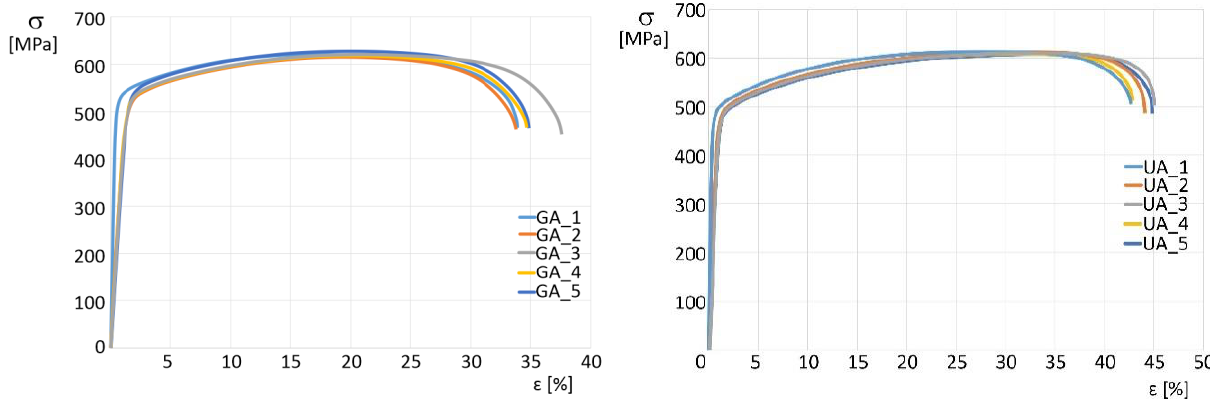
Figure 10. Stress — strain chart of tensile samples made of powders: left — PAGA; righ — UA. Table 7. The results registered during tensile testing of samples obtained using PAGA and UA powders. PAGA